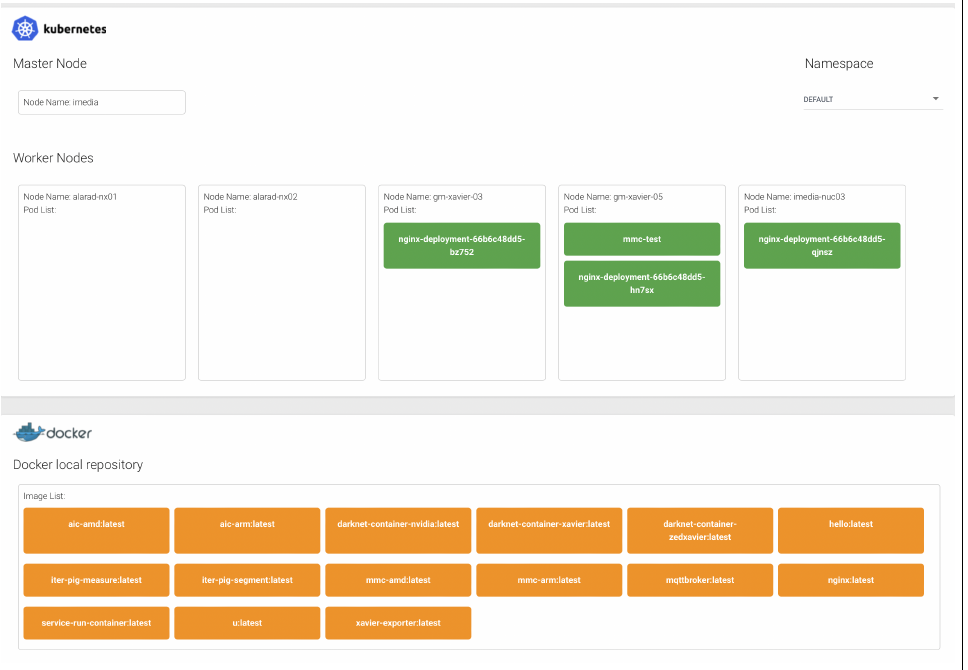
Figure 6. GUI of